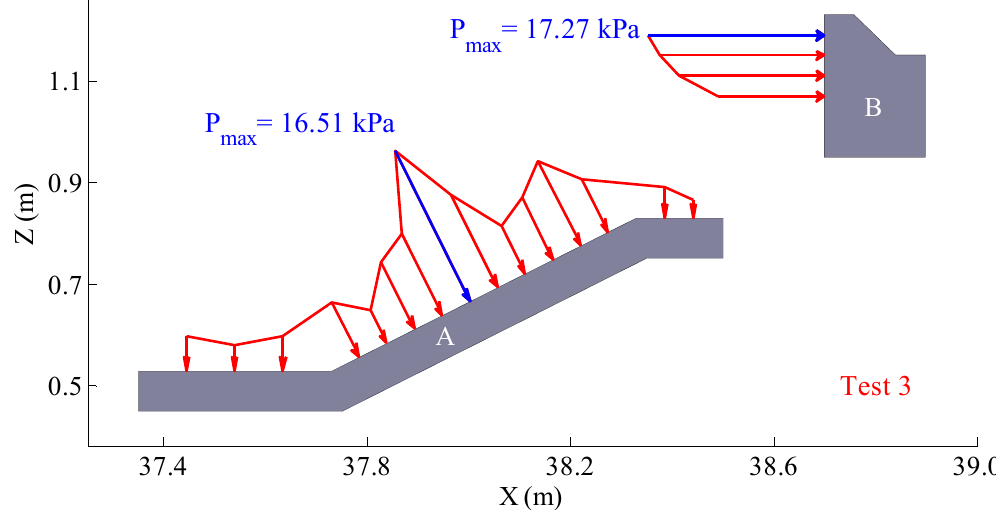
Figure 10. Distribution of the maximum wave impact on the surface of the revetment breakwater under regular wave action in Test 3.